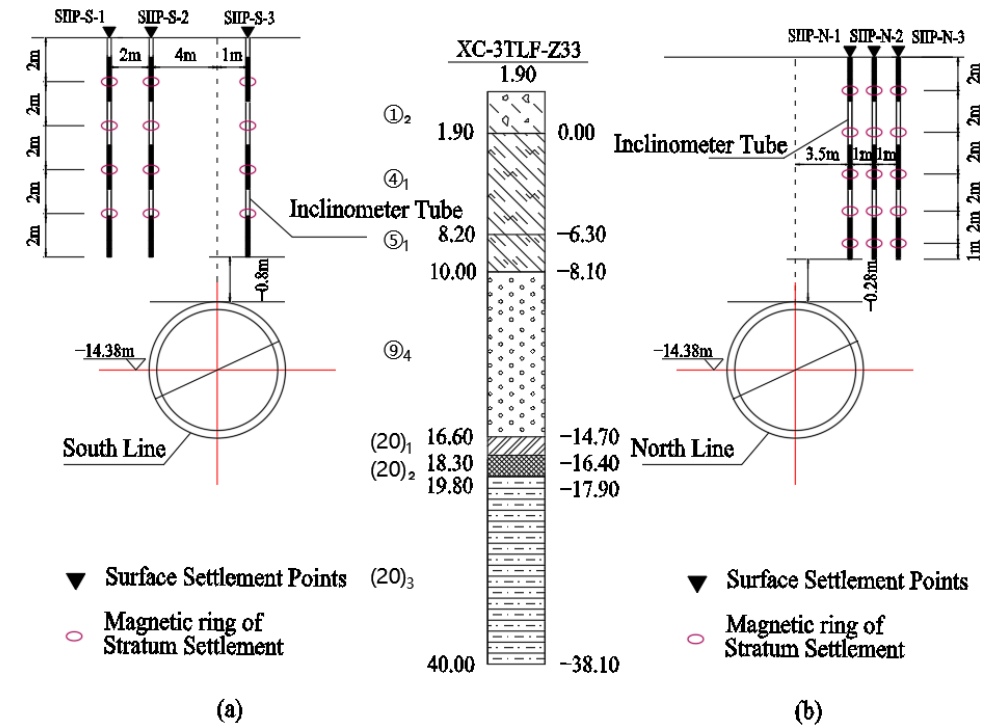
Figure 4. Profile of soil settlement measuring point: ( a ) south line; ( b ) north line.